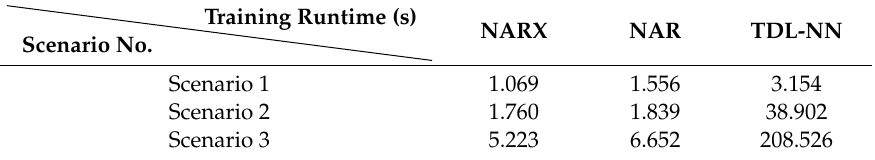
Table 5. Comparison of training run-time under di ff erent scenarios using di ff erent methods.